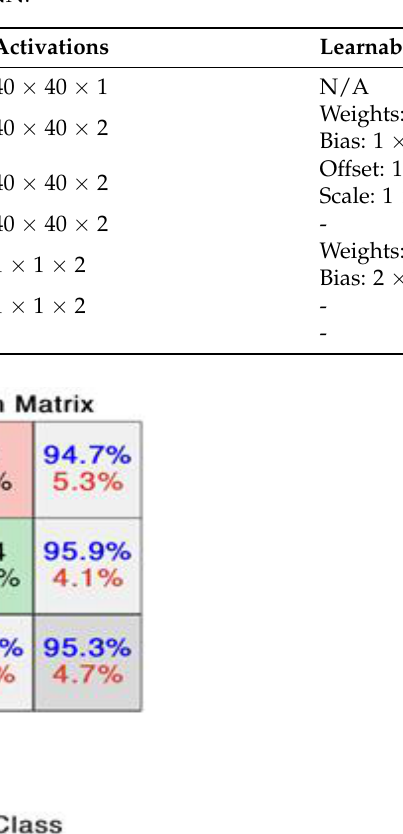
Table 6. Structure of the custom CNN.